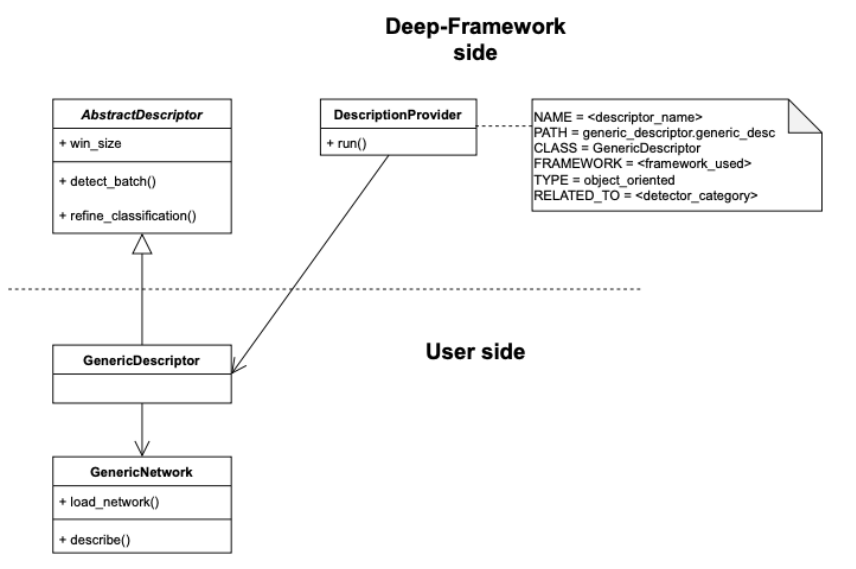
Figure 6. Descriptor class diagram, showing the relation between the Deep-Framework classes and the user-defined classes related to the Descriptor